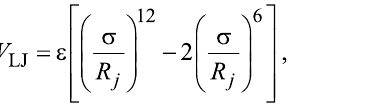
The slider is also a pointlike particle, with horizontal position x SL and mass m SL . We usually take m SL > m , but this condition is by no means required. The slider follows a guide at a fixed distance d from the chain and interacts with each chain atom through a Lennard–Jones (LJ) term. Indicating with R j = [ d 2 + ( x SL − x j ) 2 ] 1 / 2 the distance between the slider and the j- th particle, the total slider-chain interaction energy